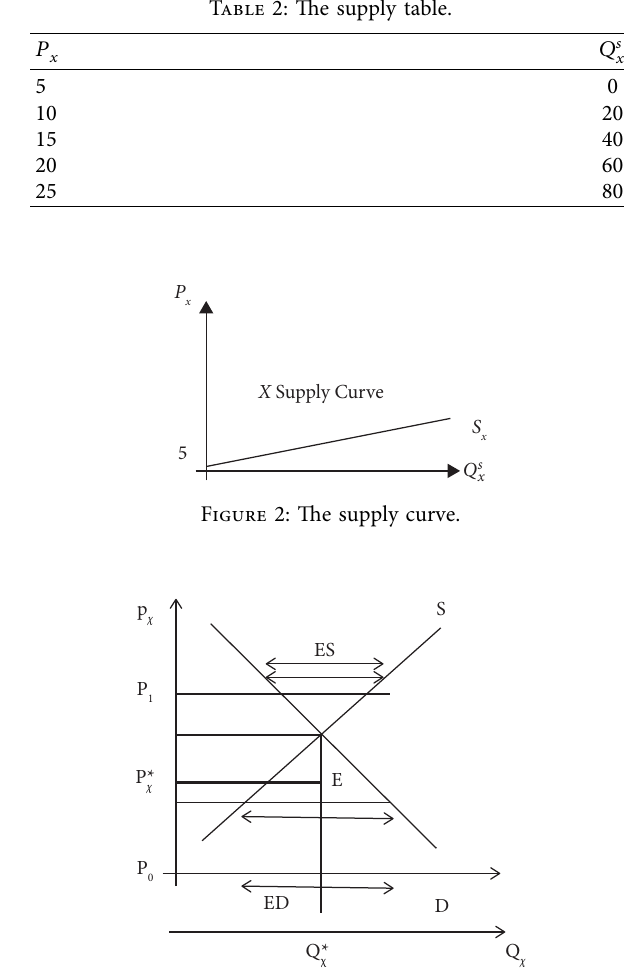
Figure 3: Te balance quantity of the goods x